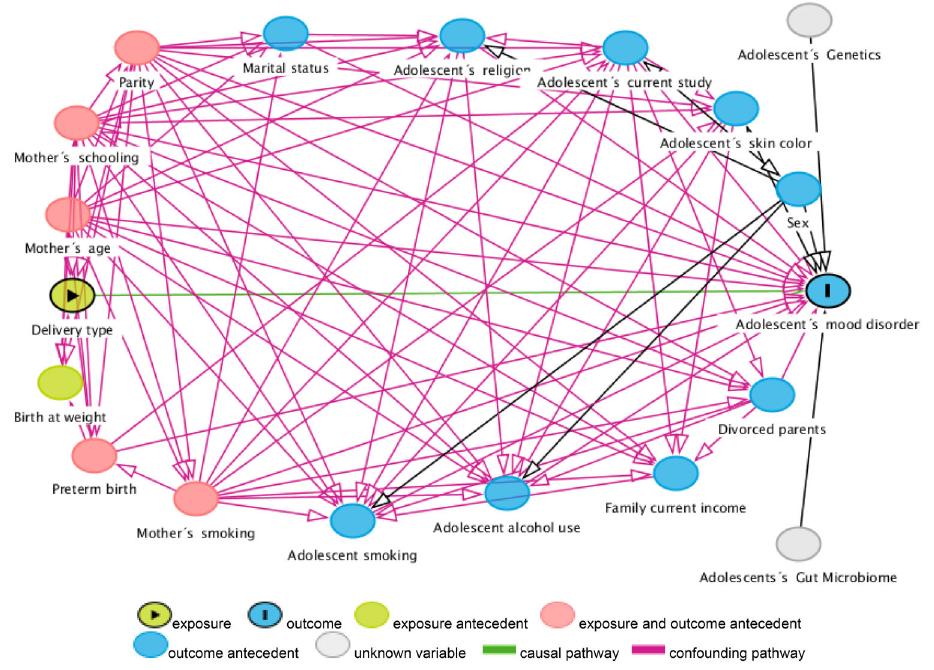
Figure 1. Directed Acyclic Graph: theoretical model of causal association between childbirth type and mood disorder in adolescents.